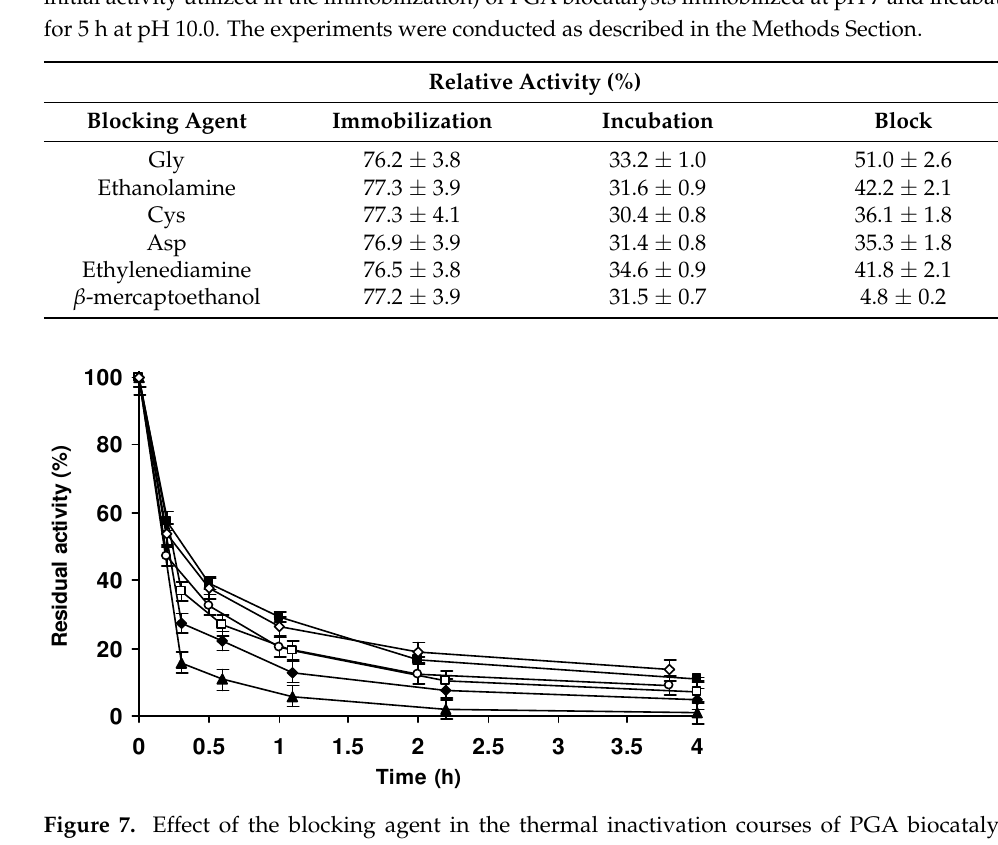
Figure 8. Thermal inactivation courses of soluble PGA in 50 mM of Tris HCl (solid squares) and Agarose-MANAE-VS-PGA immobilized at pH 7, incubated for 5 h at pH 10, and blocked with Gly (empty circles). Other details can be found in the Materials Section.